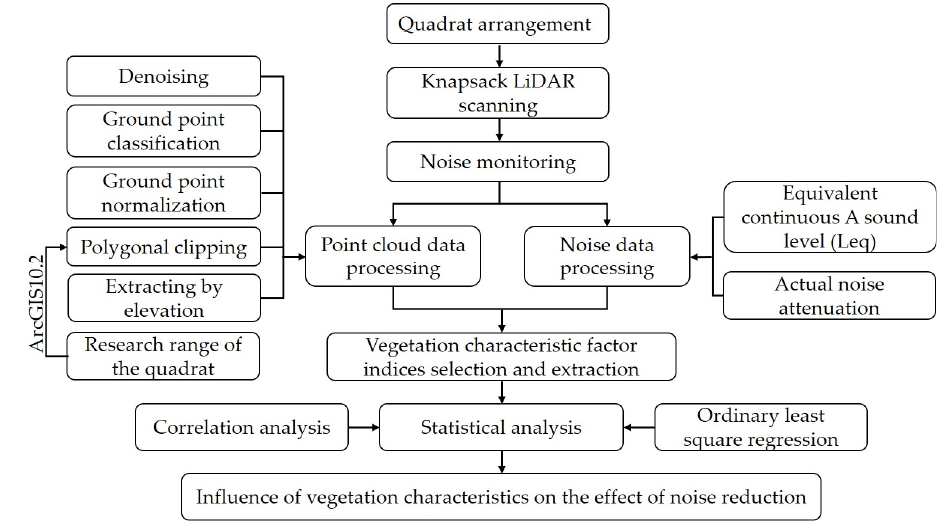
Figure 1. Workflow diagram of the study.